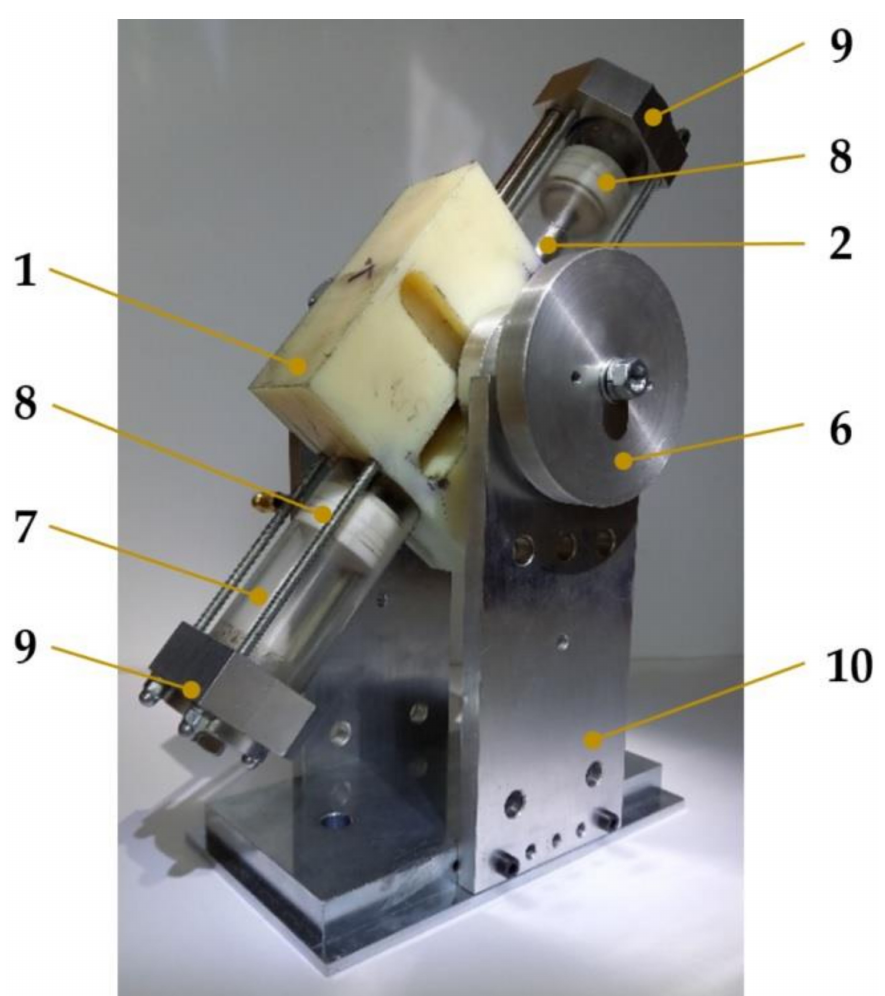
Figure 14. A real prototype of the compressed air engine design: 1—a plate, 2—a connecting rod, 6—a second output, 7—cylinders, 8—pistons, 9—heads of cylinders, 10—a